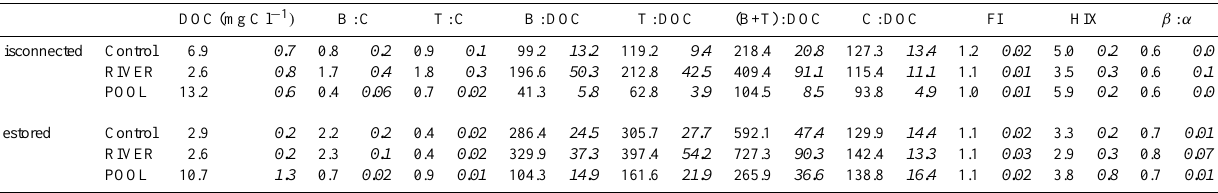
Table 3. Dissolved organic matter quality and dissolved organic carbon (DOC) over five days and standard deviation in italics ( N = 33). Peaks B and T occur at excitation wavelengths of 225–275nm and emission at wavelengths of 300–325nm and 340–385nm, respectively, and have been related to protein-like substances (peak B=Tyrosine-like, peak T=Tryptophan-like). Peak C is a fluorophore at 300–370nm excitation and 400–500nm emission and is attributed to humic-like fluorescence. Fluorescence index (FI) β : α ratio and the humification index (HIX) were calculated using the fluorescence peaks as described in the methods.